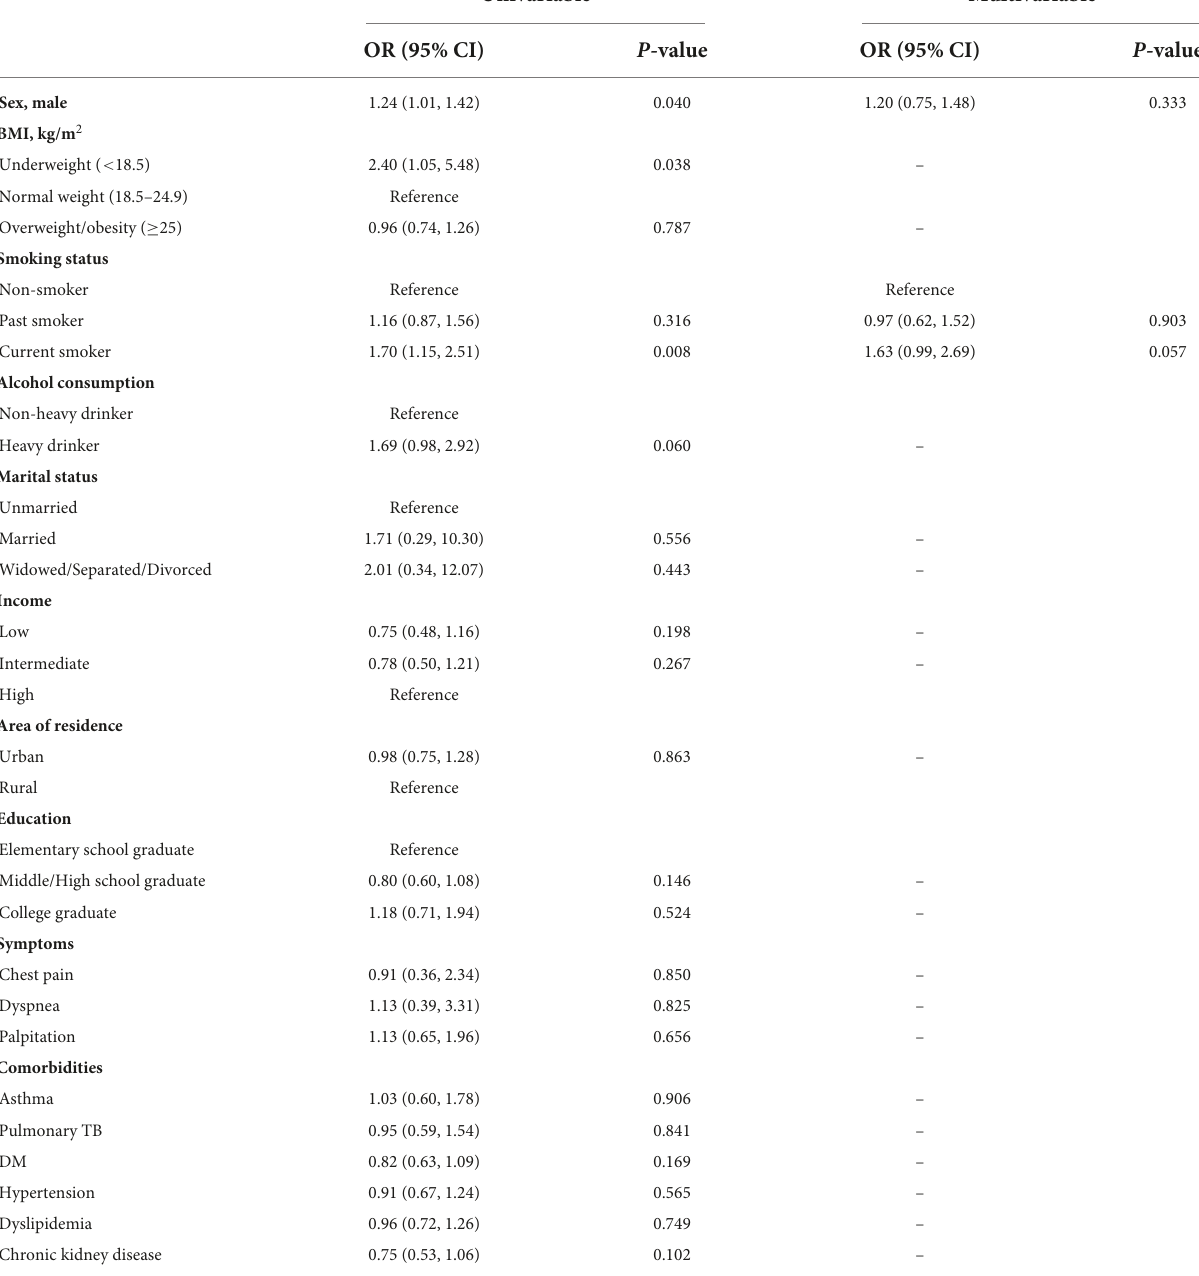
TABLE 4 Factors associated with influenza unvaccinated status in patients aged ≥ 65 years with cardiovascular